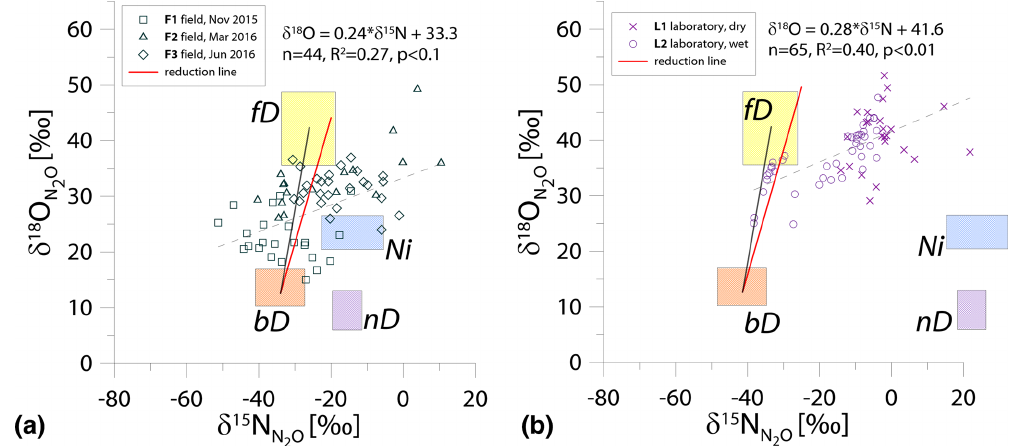
Figure 3. N 2 O isotope data of field ( a , green points) and laboratory ( b , purple points) in O / N MAP presented with literature mixing endmember values and theoretical mixing (grey line) and reduction (red line) lines. δ 15 N values are presented in relation to the δ 15 N of precursors: soil nitrate for bD and fD or ammonium for nD and Ni. δ 18 O values of mixing endmember bD, nD, and fD are presented in relation to the mean measured ambient water of − 6.4‰. Hence, the mixing endmember ranges present the expected δ 15 N N originating from a particular pathway in these study conditions. The dashed line shows the linear fit for all the points with its equation and statistics